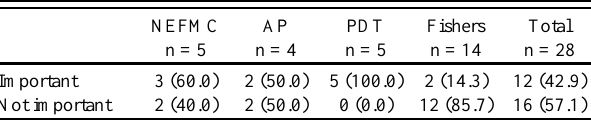
Table 3 . Participants’ opinions about the importance of public input to the outcome of Western Gulf of Maine Area Closure establishment. Values in parentheses are